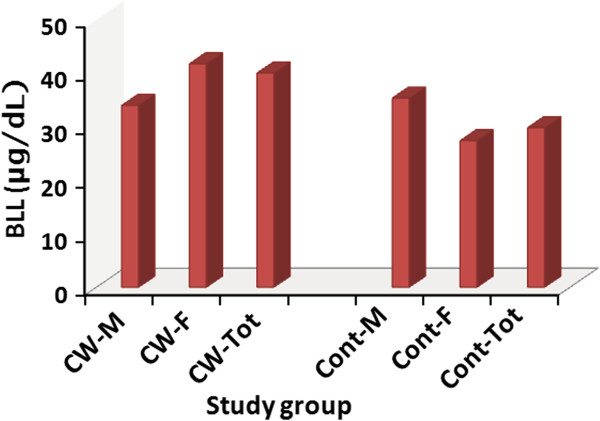
Mean BLLs of the construction workers and non-construction workers. M (male), F (female), CW (construction workers), Cont (controls), Tot (total).